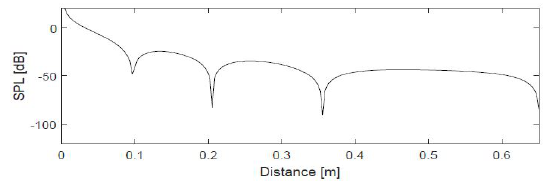
Figure 9. Sound pressure level of the experimental